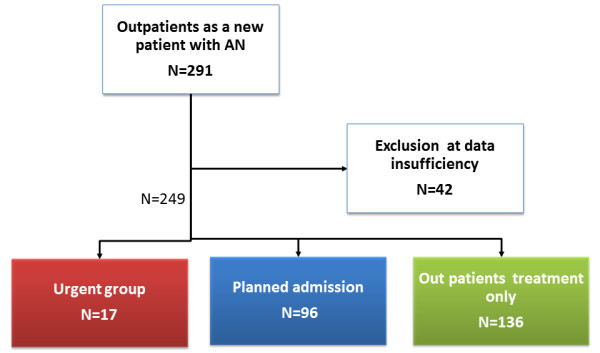
Algorithm for classification into three groups. Urgent group: This group consisted of patients hospitalized with disturbance of consciousness and/or difficulty walking on the day of consultation. Planned admission group: This group consisted of AN patients hospitalized for therapeutic purposes up to one year after the day of consultation. Outpatient treatment only group: Patients not admitted in the year after the initial consultation.